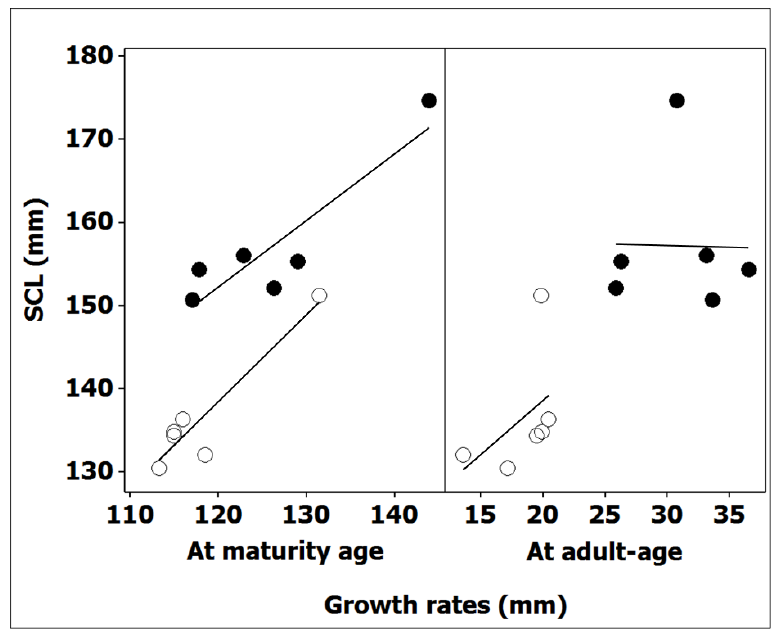
Figure 4. Relationship between body size in adult males (white circles) and females (black circles) and growth rates acquired at both the time of sexual maturity and during the adult life of Algerian T. graeca. Equations of regression lines are for males and females: Y1 = 12.8 + 1.05X (r Pearson = 0.94, p < 0.01, n = 6), Y2 = 113.0 + 1.31X (r Pearson = 0.46, p = 0.362, n = 6) and Y1 = 55.7 + 0.80X (r Pearson = 0.90, p < 0.05, n = 6), Y2 = 159.0 - 0.05X (r Pearson = -0.02, p = 0.967, n = 6), respectively. Significant correlations are highlighted by underlining.